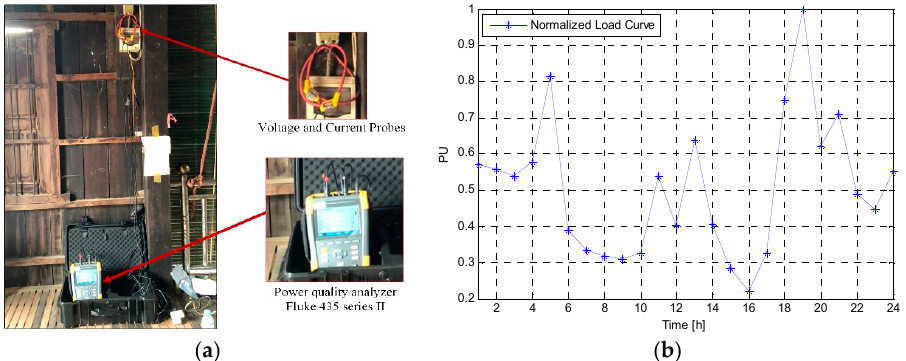
Figure 5. ( a ) Setup of load profile measurement for the simulation and ( b ) normalized daily load curve for the simulation [26].